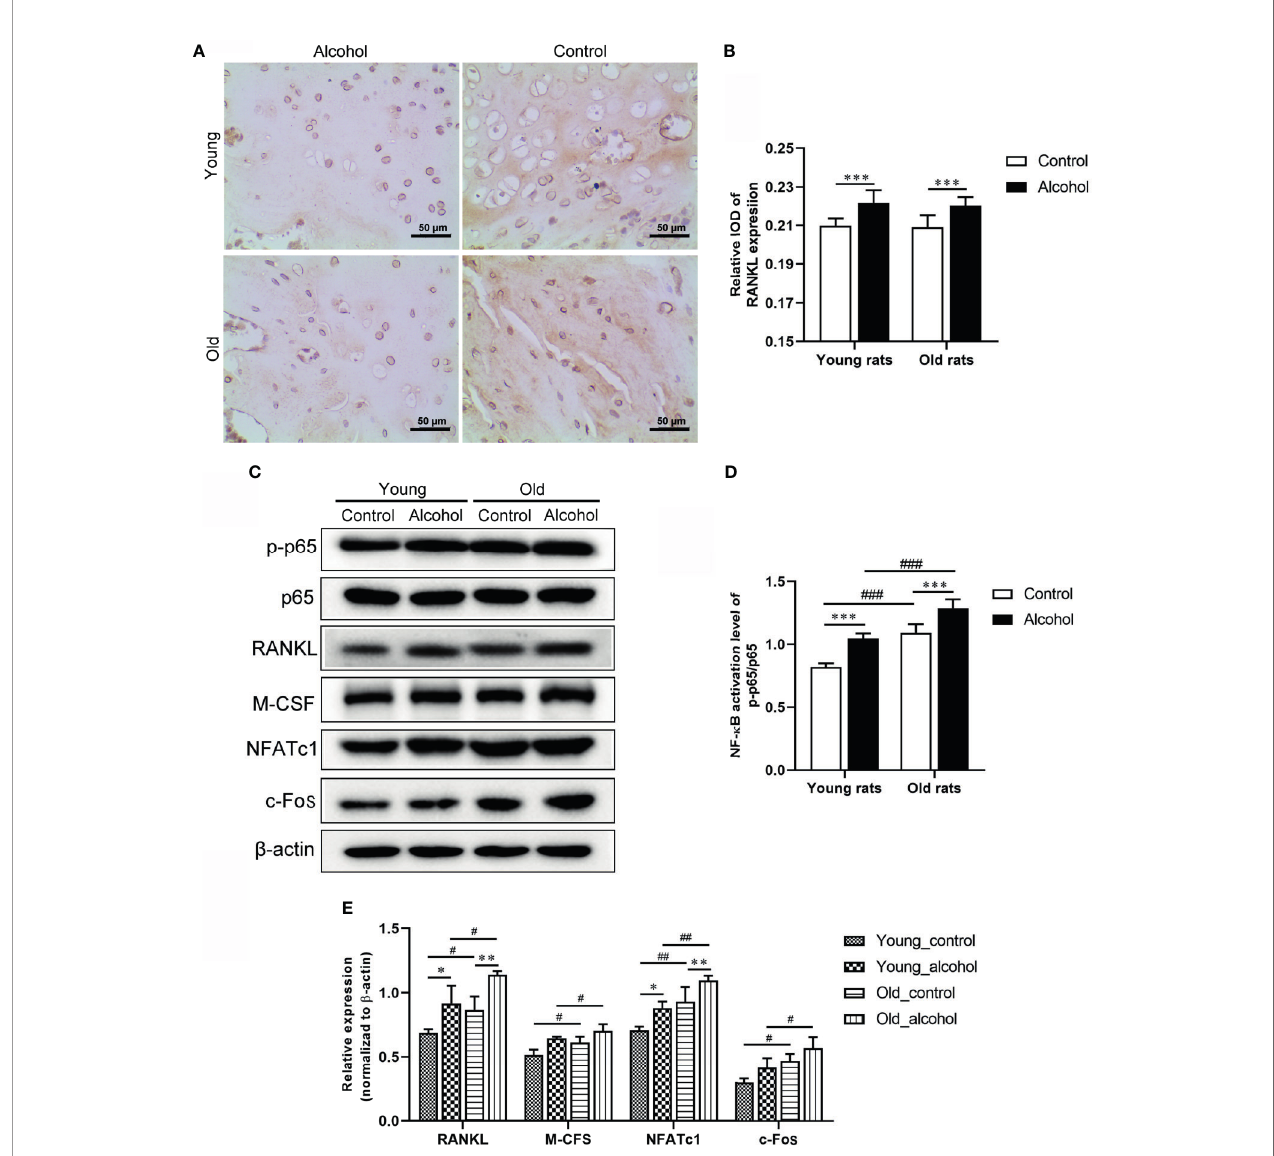
FIGURE 2 | Effects of alcohol on osteoclast activation signaling pathway in young and old rats. (A) The expression of RANKL in trabecular bone was observed by IHC; (B) The relative IOD of RANKL expression in IHC; (C) The protein expression of osteoclast activation signaling pathway was detected by WB; (D, E) Densitometry analysis of the intensity of the protein bands. Data were shown as mean ± SD. n=6, * P < 0.05, ** P < 0.01, *** P < 0.001, compared with control of the same age; # P < 0.05, ## P < 0.01, ### P < 0.001, the same group compared with young